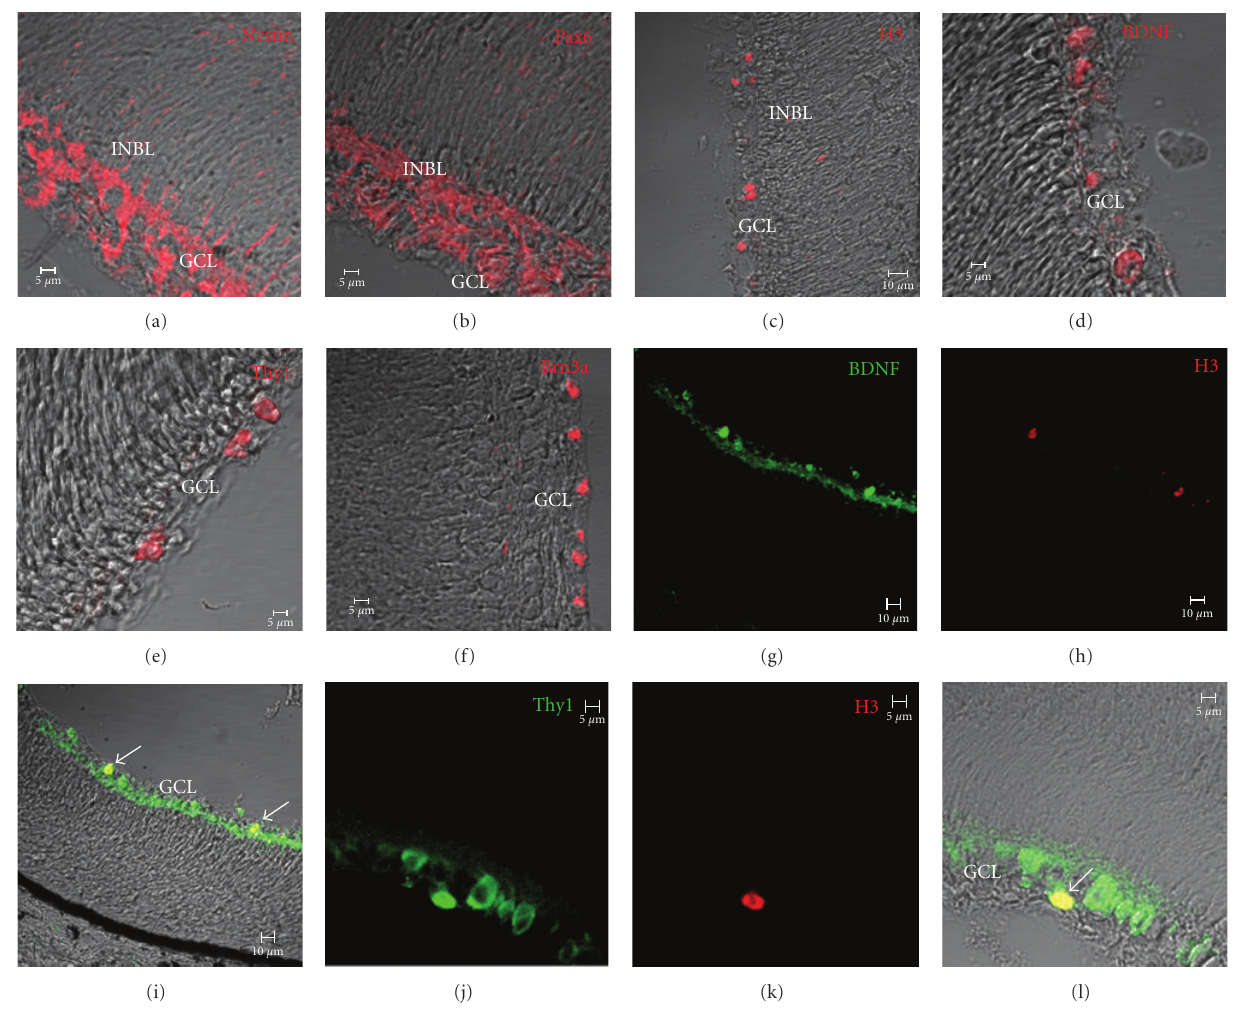
Figure 4: Immunofluorescent staining of Nestin (a) and Pax6 (b) during neonatal stage was observed in the INBL. (c) H3 only revealed in the GCL and did not co-localize with stem cell markers. BDNF (d), Thy1 (e) and Brn3a (f) staining showed the typical morphology of ganglion cells localized in the GCL (red cells). A number of cells marked with BDNF ((g)–(i)) and Thy1 ((j)–(l) were evidently proliferating as they were positive to H3 protein